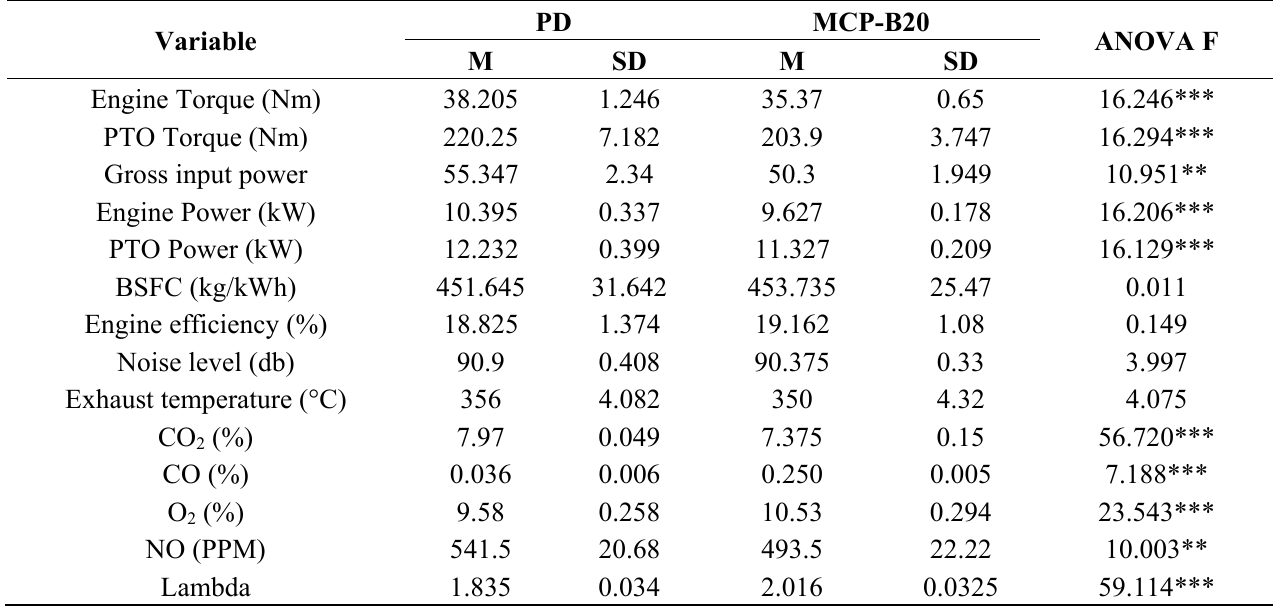
Table 3. Descriptive statistics and ANOVA summary for tractor engine performance and emissions at WOT, rated PTO speed 540 RPM (engine speed 2600 RPM).